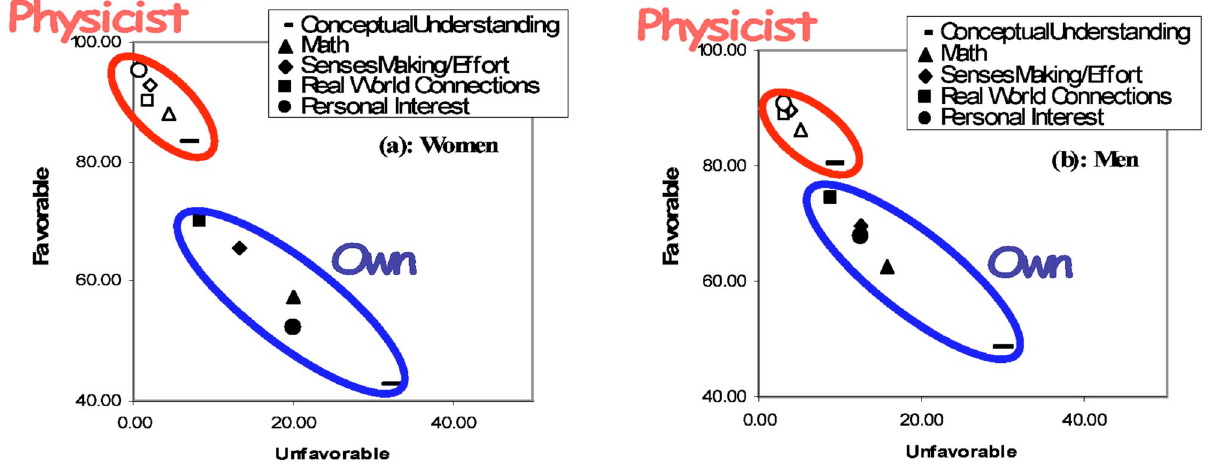
FIG. 3. (cid:1) Color (cid:2) Women’s. (cid:1) a (cid:2) (cid:1) N =88 (cid:2) and men’s (cid:1) b (cid:2) (cid:1) N =62 (cid:2) responses to “What would a physicist say?” and “What do YOU think?”